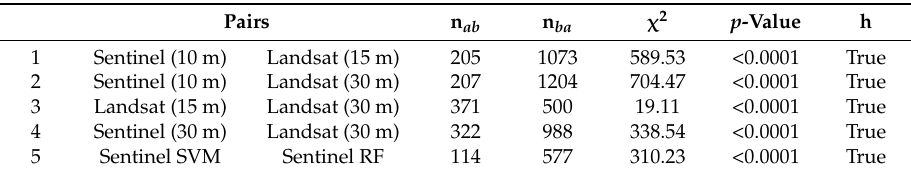
Table 8. McNemar’s test results for all different classification pairs (spatial resolution is defined in